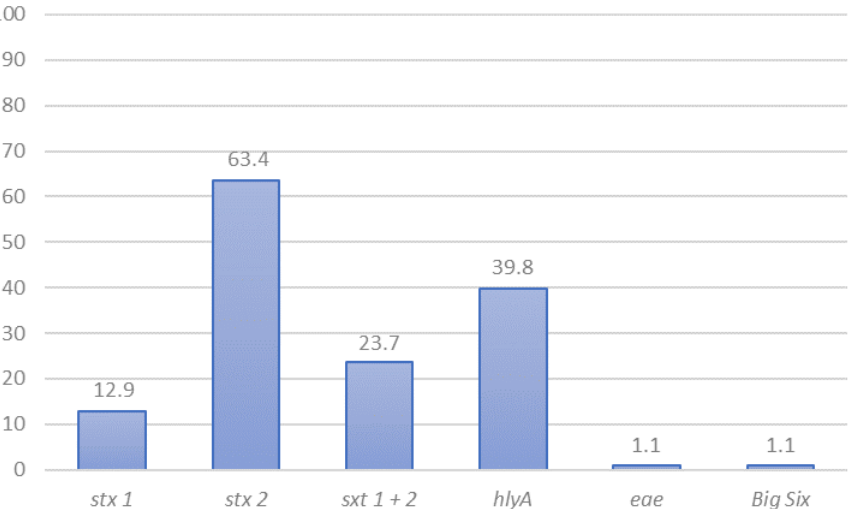
Figure 1. Genotypic characterization of non-O157 STEC isolated from cattle in Chile ( n = 93) by the presence of virulence genes (%). Genes were detected by PCR as described in references [22,23,25,26].